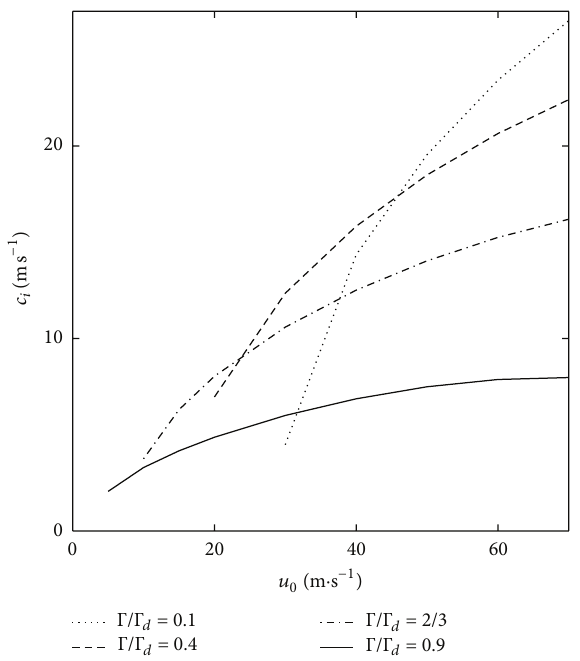
Figure 8: Imaginary part of phase speed 𝑐 𝑖 versus vertically averaged zonal wind velocity 𝑢 0 for different values of dimensionless temperature lapse rate Γ/Γ 𝑑